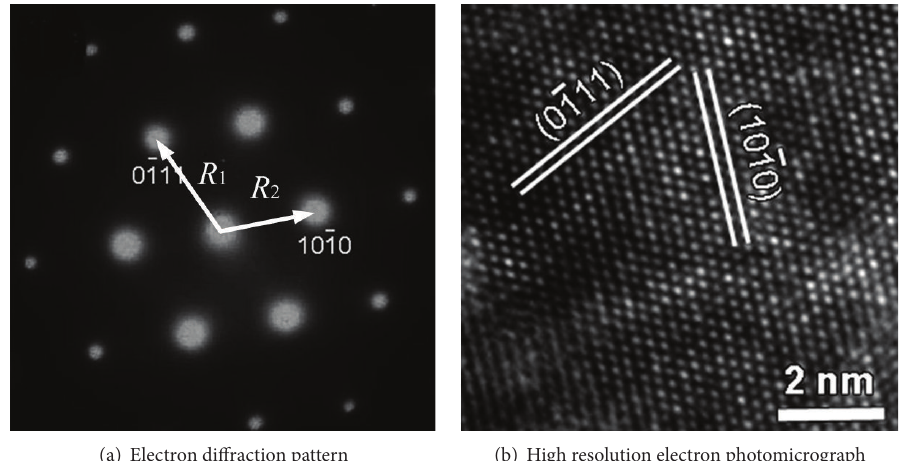
Figure 4: Calibration process of 𝛼 phase structure analysis for titanium alloy.